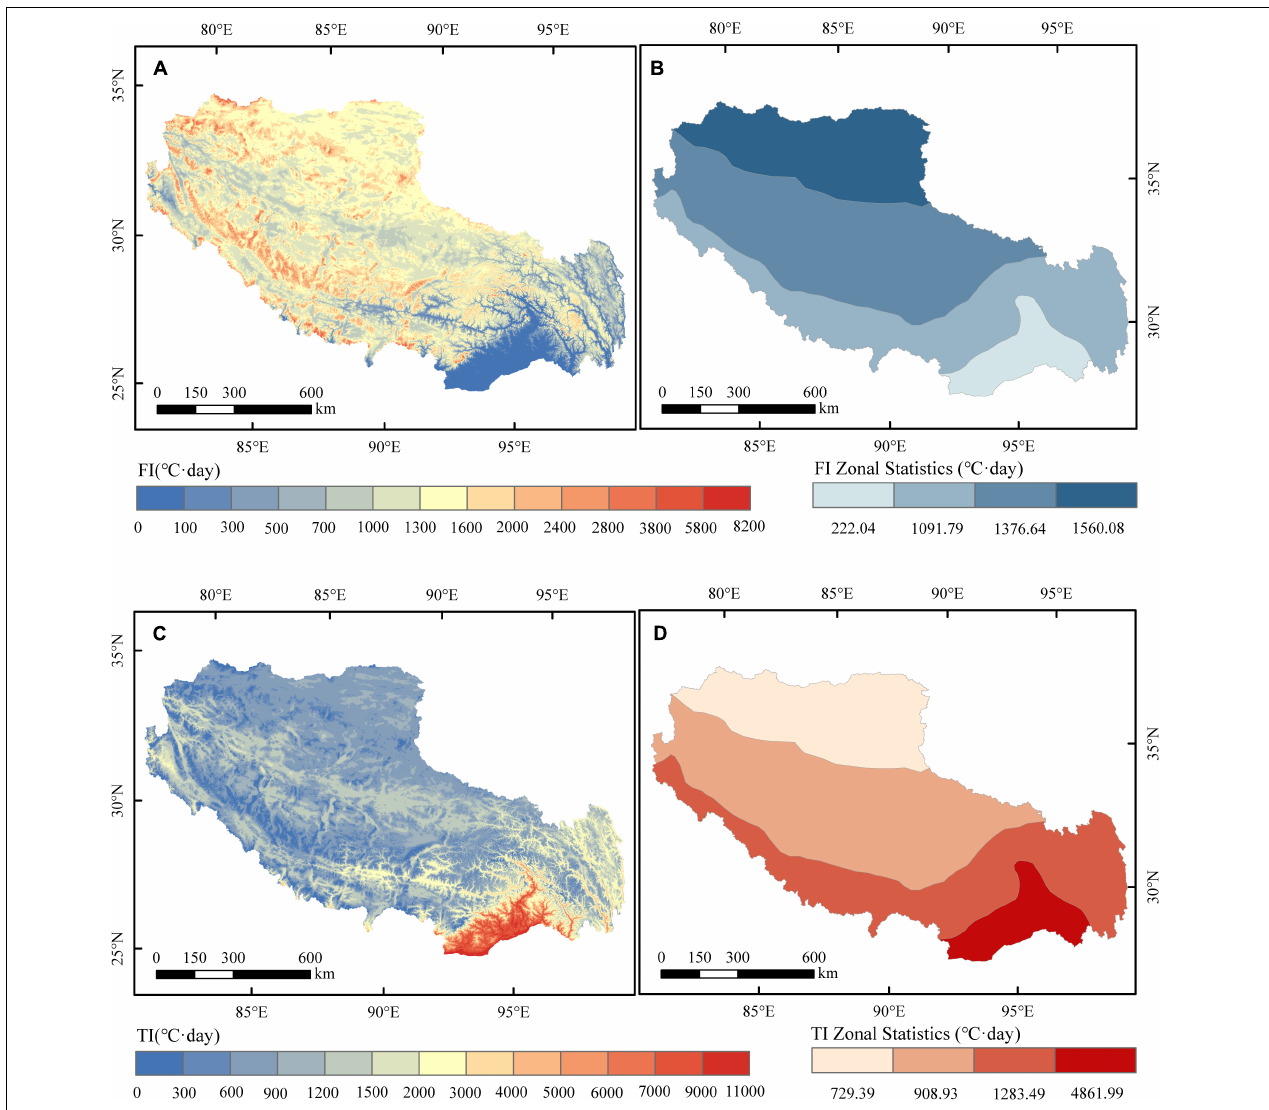
FIGURE 2 | (A) The spatial patterns of the long-term (1978–2017) freezing index (FI) and (B) 4 parts zonal statistics over Tibet. (C) The spatial patterns of the long-term (1978–2017) thawing index (TI) and (D) 4 parts zonal statistics over Tibet.